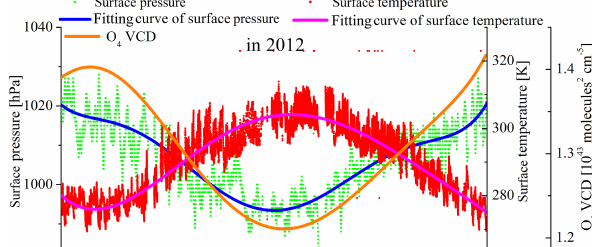
Table 2. Different filters and corresponding thresholds applied to the retrieved SCDs. Also shown are the corresponding fractions of removed data (SZA: solar zenith angle; RIO: relative intensity offset; RMS: root mean square of the spectral residual). O 4 and NO 2 SO 2 HCHO Filter Percentage Filter Percentage Filter Percentage SZA < 75 ◦ 6.2% SZA < 75 ◦ 5.8% SZA < 75 ◦ 6.1% RIO < 0.01 5.6% RIO < 0.01 1.1% RIO < 0.01 7.1% RMS < 0.003 0.3% RMS < 0.01 0.2% RMS < 0.003 0.2%